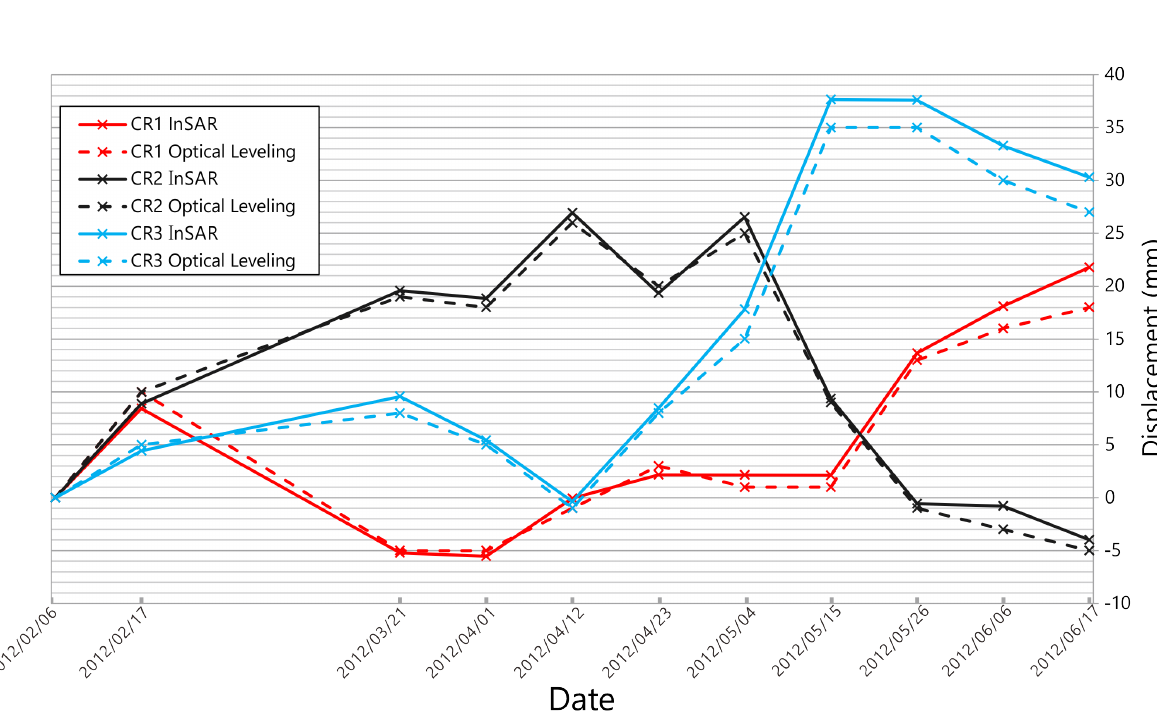
Figure 11. The vertical displacements time series retrieved by InSAR in comparison to the result retrieved by the leveling survey. Note that there are biases between the two values that increase with time. This point will be discussed